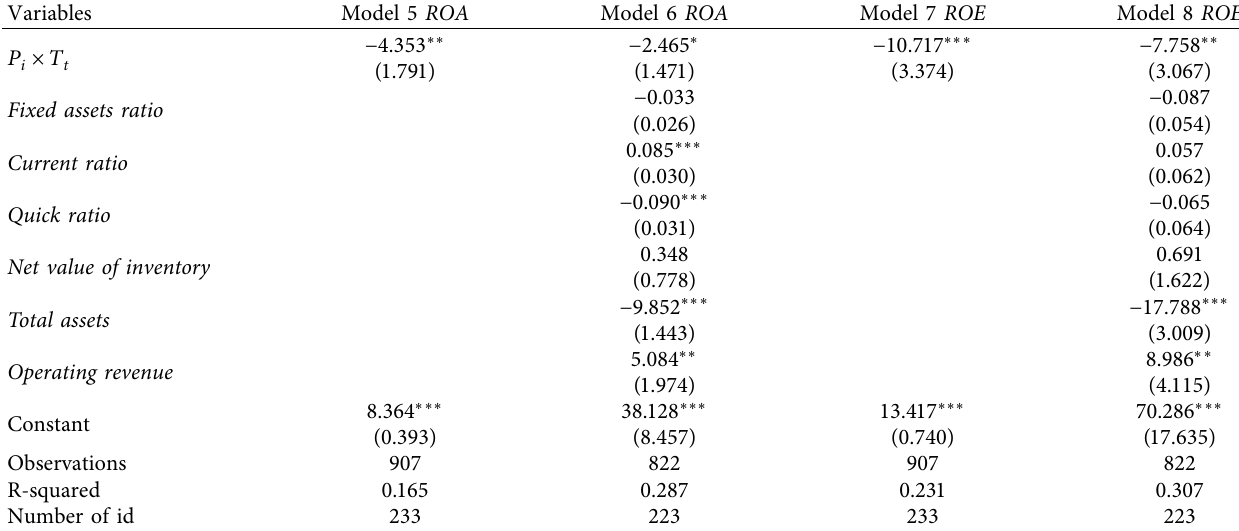
Table 2: Regression results based on PSM-DID.